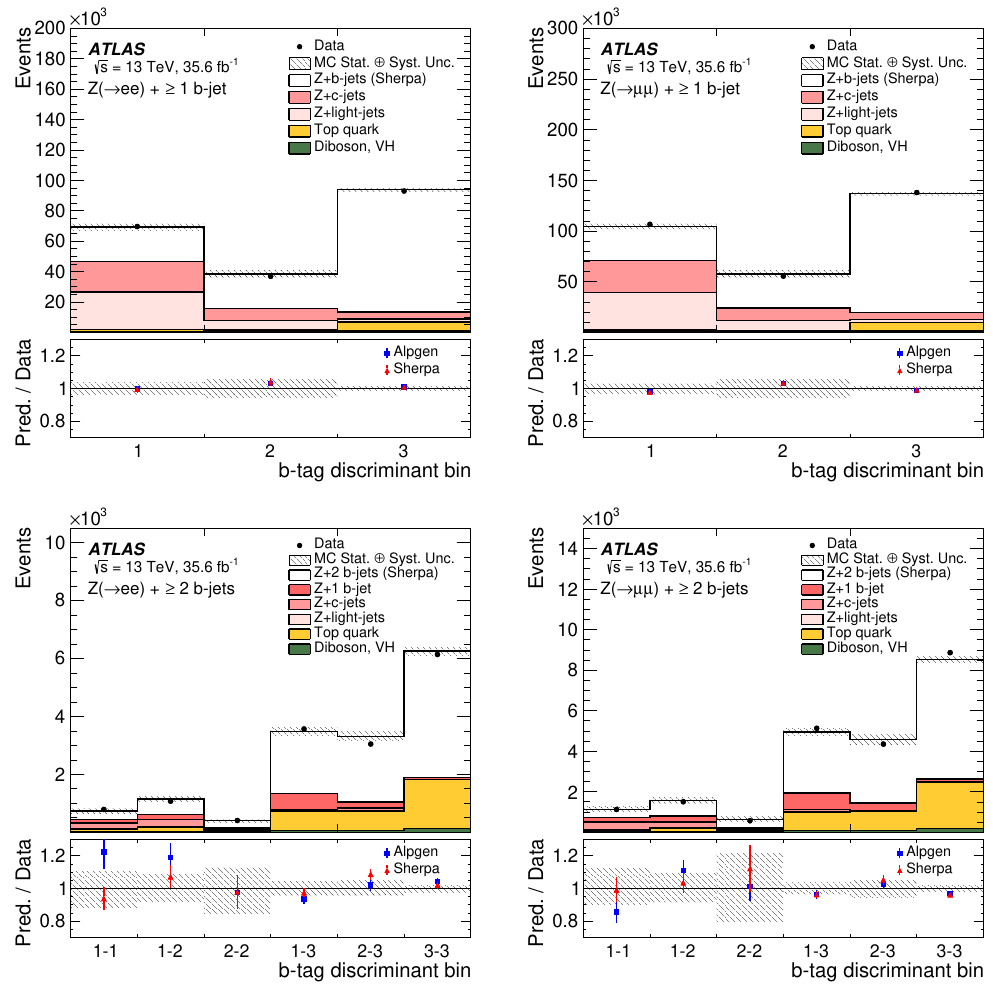
Figure 2 . Post-(cid:12)t b -tagging discriminant distributions for the electron (left) and muon (right) channels in the 1-tag (top) and 2-tag (bottom) signal regions. The lower panels display the ratios of the predictions to data using the signal and Z +jet background simulation either from Sherpa (red) or Alpgen (blue). Systematic and statistical uncertainties for the predicted distributions are combined in the hatched band, and the statistical uncertainty, estimated with pseudo-experiments, is shown on the data points. The systematic uncertainties account for both the detector-level uncertainties and the theory uncertainty of the non- Z